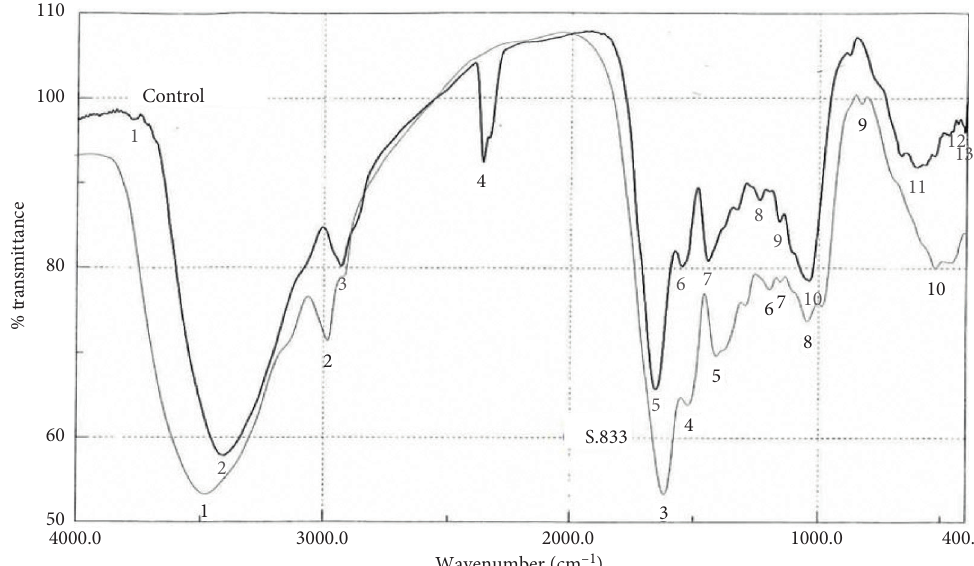
Figure 8: FTIR spectra analysis of the leather of the manuscript compared to a standard leather